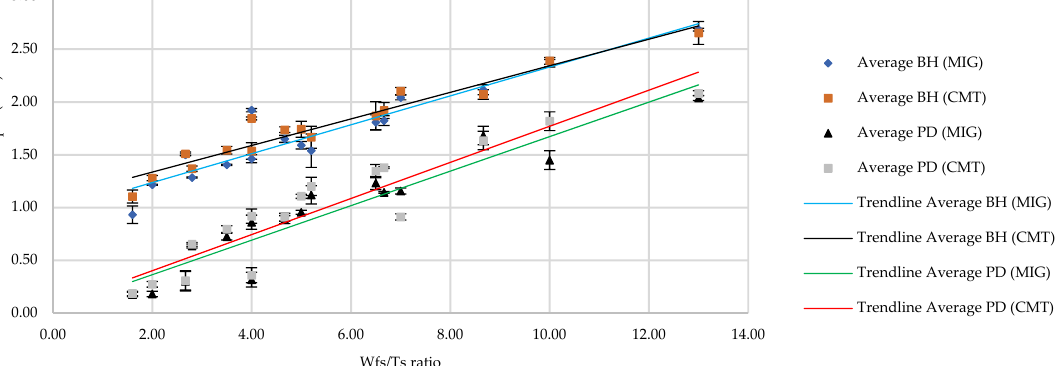
Figure 9. Sample dimensions plotted against Wfs/Ts ratios.